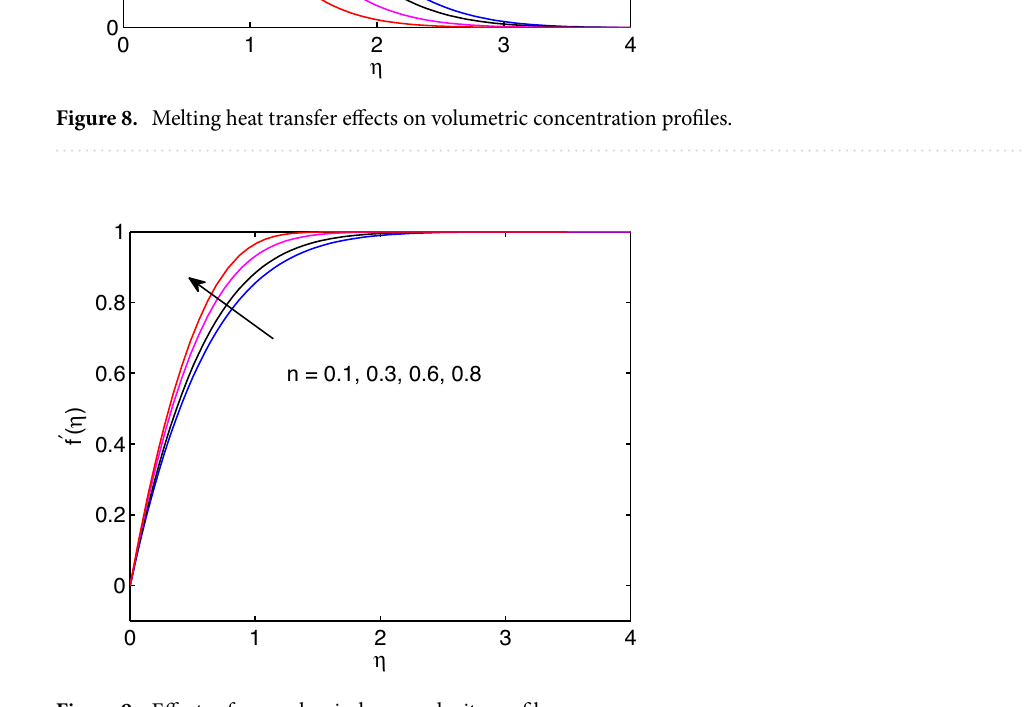
Figure 9. Effects of power law index on velocity